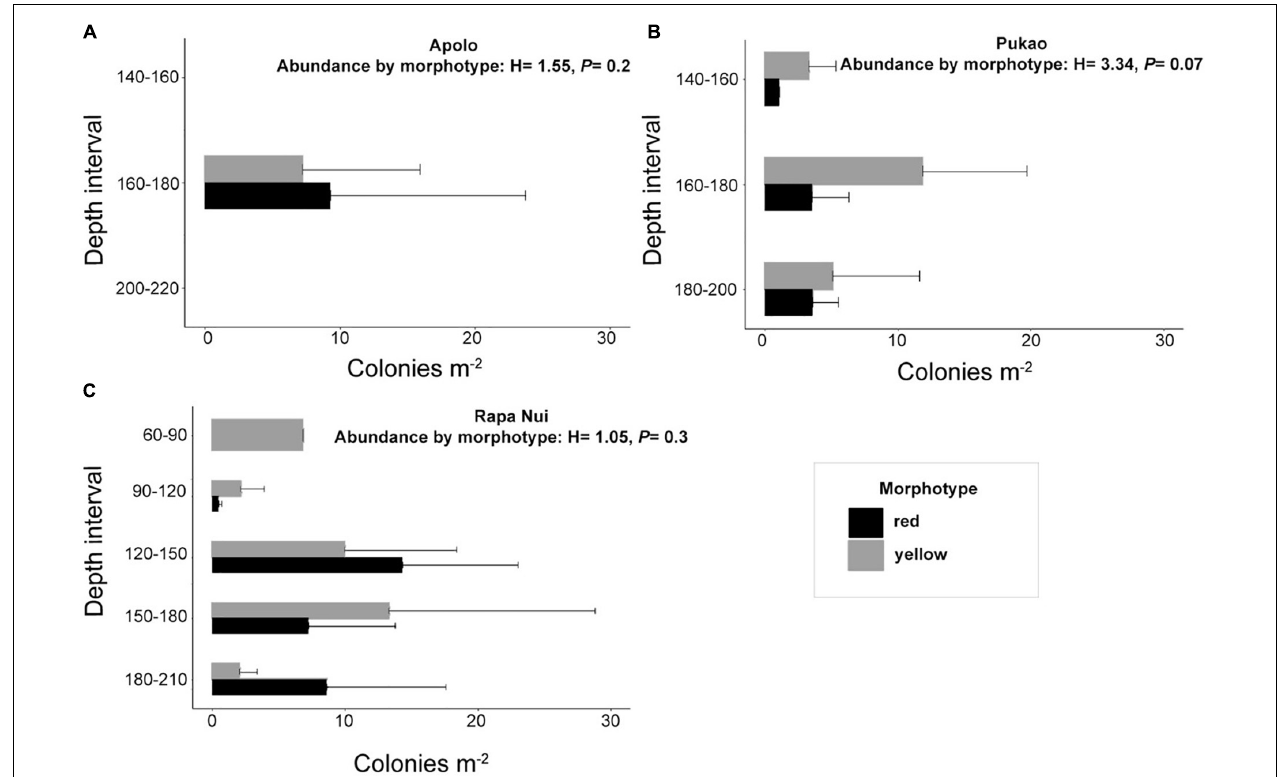
FIGURE 6 | Abundance (colonies m − 2 ± SE) of the yellow and red morphotypes by depth interval on (A) Apolo peak, (B) summit of Pukao seamount, and (C) around Rapa